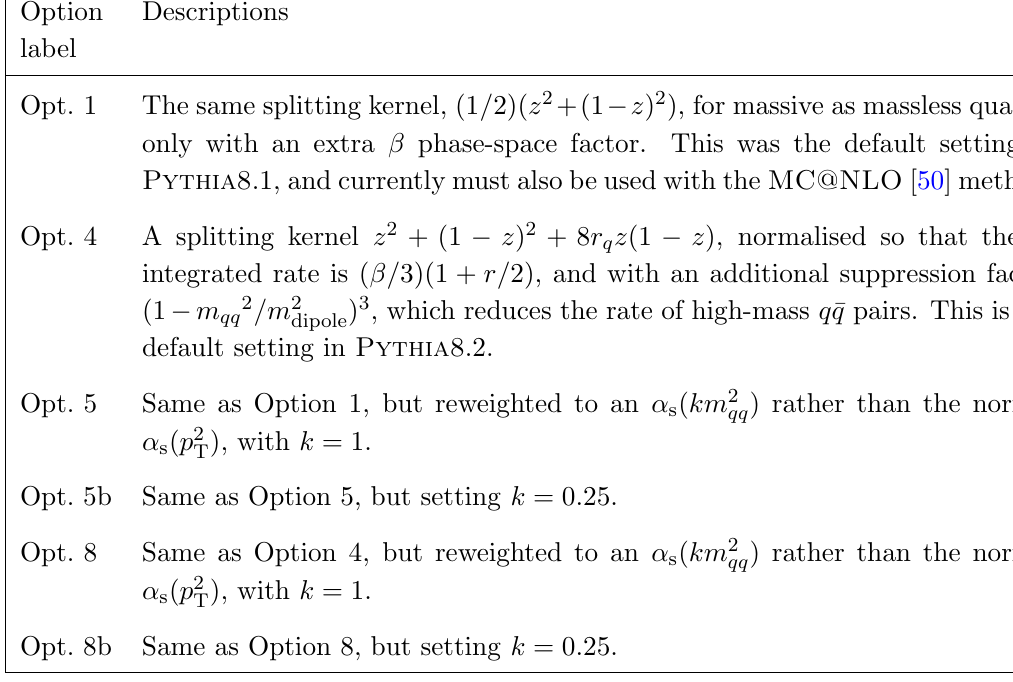
=m 2 , (cid:12) = p 1 (cid:0) 4 r q , with m q q qq